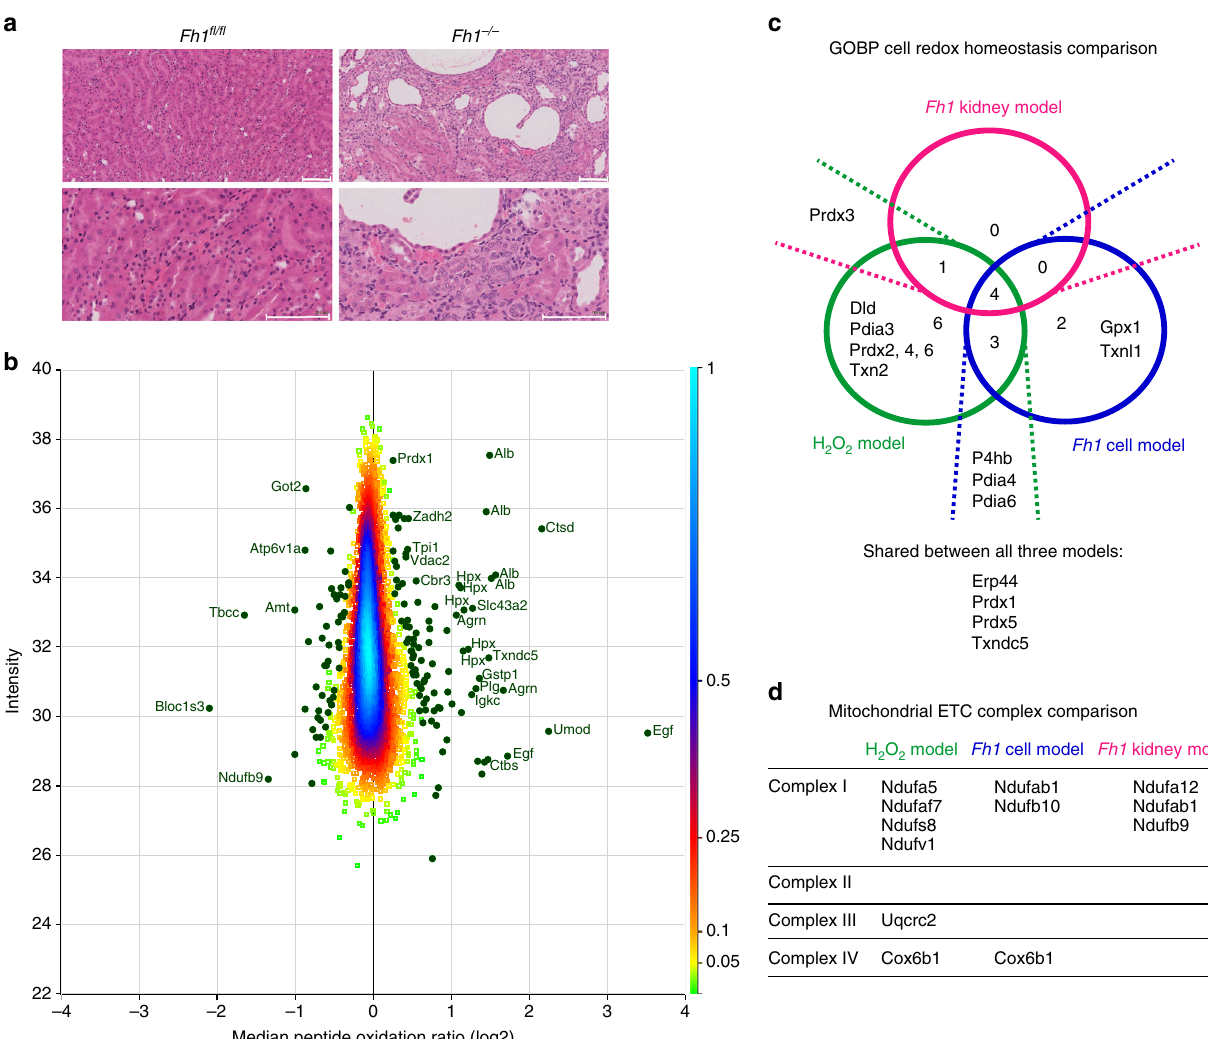
Fig. 8 Analysis of mouse kidneys shows oxidation of proteins from various tissue compartments. a Representative image of Fh1 fl / fl and Fh1 − / − mouse kidney tissue slices stained for H&E, taken at 20× magni fi cation. Scale bar indicates 100 µ m. b Density scatterplot displaying log 2 median peptide oxidation ratios vs. peptide intensity in Fh1 − / − mouse kidney tissue compared to Fh1 fl / fl kidney tissue. Every square represents a unique peptide; colour scale of the density of the data points in the corresponding region is indicated on the right. Highlighted green circles are signi fi cantly oxidised (positive values) and reduced (negative values) peptides. Gene names of corresponding peptides are displayed for the most signi fi cantly oxidised or reduced peptides. c Venn diagram showing overlap and exclusivity of proteins involved in cell redox homoeostasis as de fi ned by GOBP that were signi fi cantly modi fi ed in the acute and chronic oxidative stress cell and kidney models. d Comparison of components of the mitochondrial electron transport chain complexes that were signi fi cantly modi fi ed in the acute and chronic oxidative stress cell and kidney models. a Representative images of single histology slides; b based on the comparison of 1 mouse per genotype, using four replicate tissue slices per mouse. c , d Based on four independent experiments,